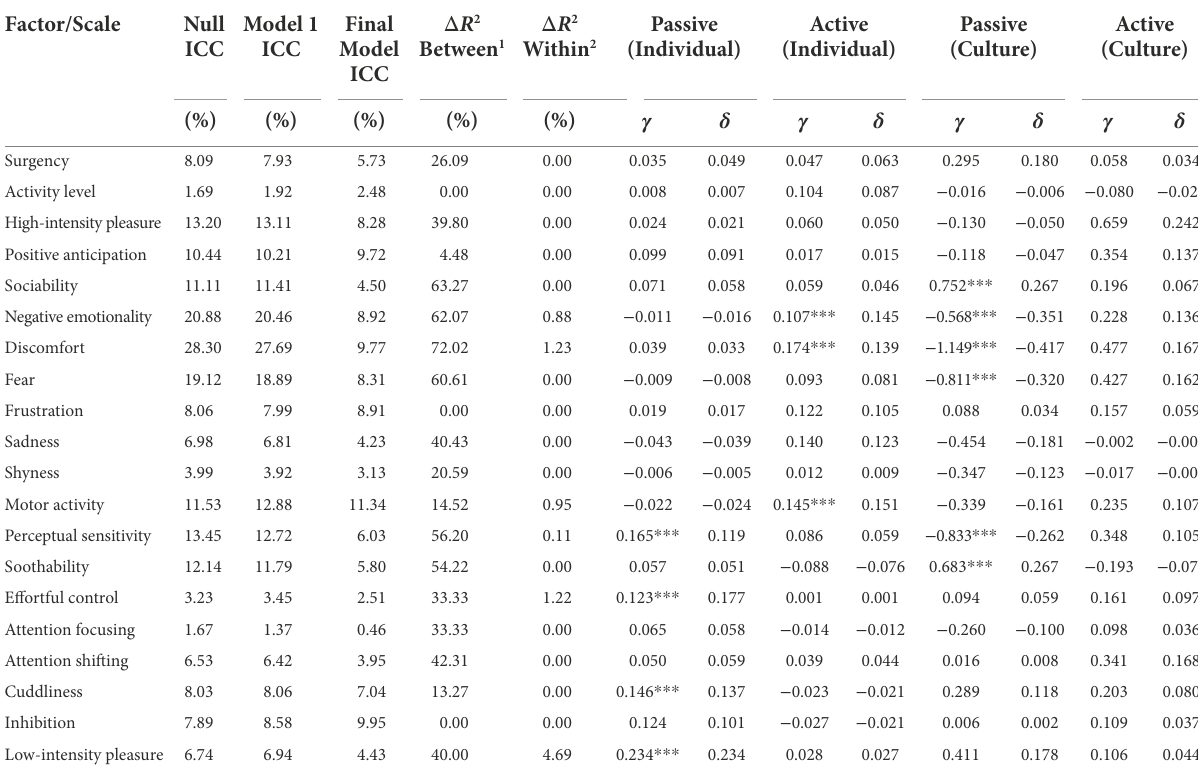
TABLE 2 Summary statistics for final